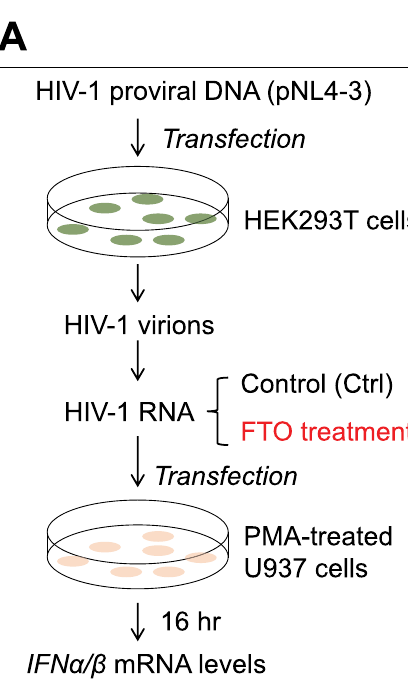
Fig 2. Inhibition of m 6 A modifications of HIV-1 RNA by recombinant FTO increases IFN-I induction. (A) A schematic of the experimental approach. (B) m 6 A levels of HIV-1 genomic RNA were reduced by treatment with recombinant demethylase FTO and 50 ng of RNAs were used to confirm the m 6 A levels by dot-blotting. Methylene blue (MB) staining was used as an RNA loading control. (B) and (C) 250 ng of the above RNAs were transfected in PMA-differentiated U937 cells. At 16 hr post-transfection, IFN- α and IFN- β mRNA levels were measured by RT-qPCR. The results are shown as means ± S.D. of three independent experiments. Mann-Whitney t-test was used for statistical analysis. ��� P < 0.0005, compared with control (Ctrl) samples.